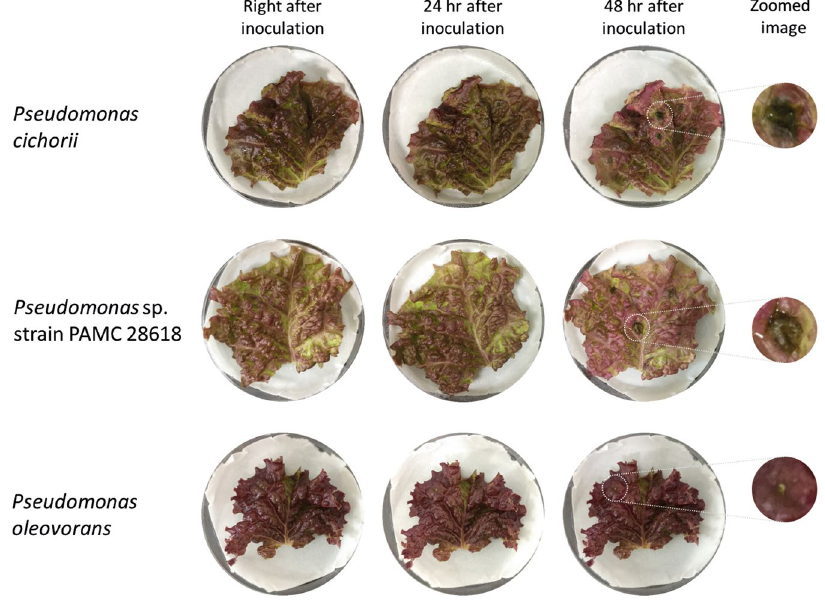
Figure 8. Phenotypical toxicity test was performed by inoculating lettuce leaves with Pseudo- monas cichorii , strain PAMC 28618 or P. oleovorans as a control and leaves were observed every 24 hr for 48 hr. After 48 h, the spot that had been inoculated with P. cichorii and strain PAMC 28618 were showed rot disease, but lettuce inoculated with P. oleovorans did not develop rot